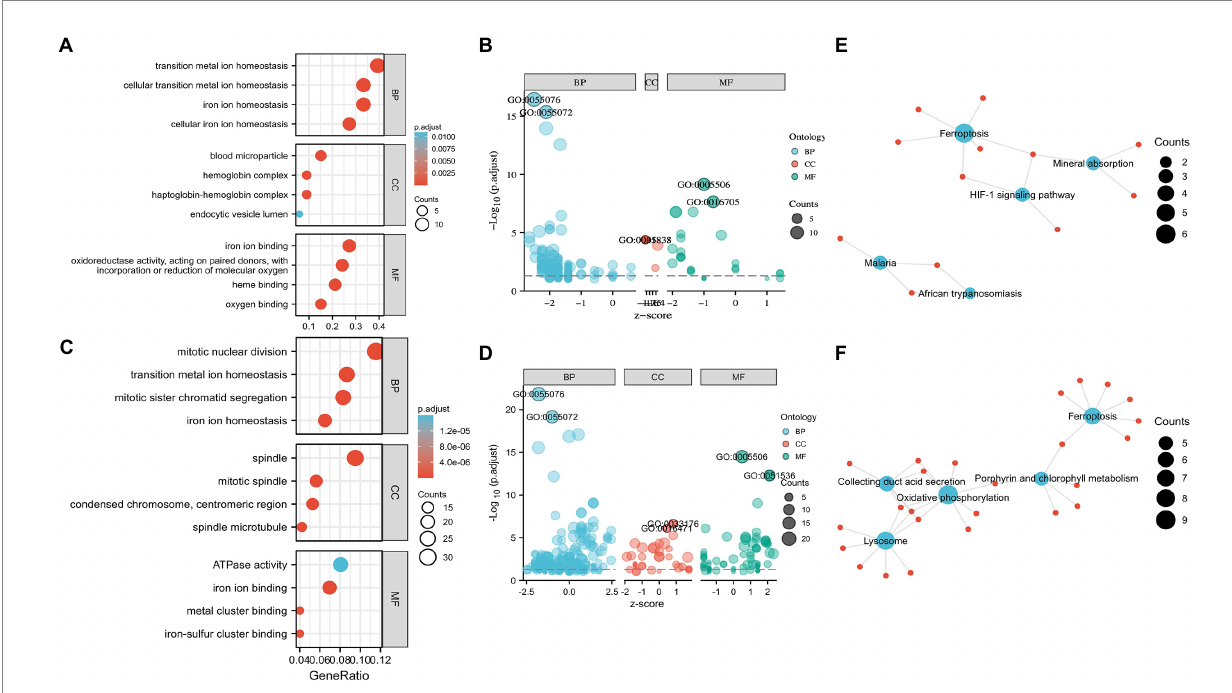
FIGURE 2 Enrichment analysis for the differentially expressed genes (DEGs) in circulation and the myocardium. (A) Gene Ontology (GO) enrichment analysis, (B) Bubble plot of enriched GO terms in GSE79962. (C) GO enrichment analysis, (D) Bubble plot of enriched GO terms in GSE46955. (E) Kyoto Encyclopedia of Genes and Genomes (KEGG) pathway analysis in GSE79962. (F) KEGG pathway analysis in GSE46955. Abbreviations: BP, biological process; CC, cellular component; MF, molecular function.